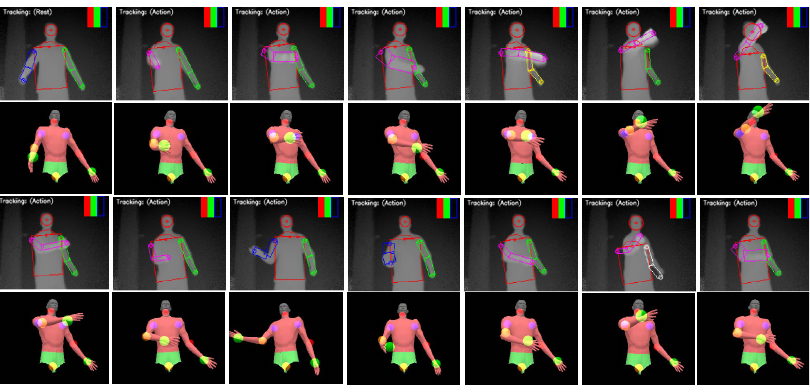
Figure 8. Upper body pose tracking for frisbee throwing motion. Rows 1 and 3: depth image sequence with the detected body parts. Rows 2 and 4: corresponding reconstructed pose.